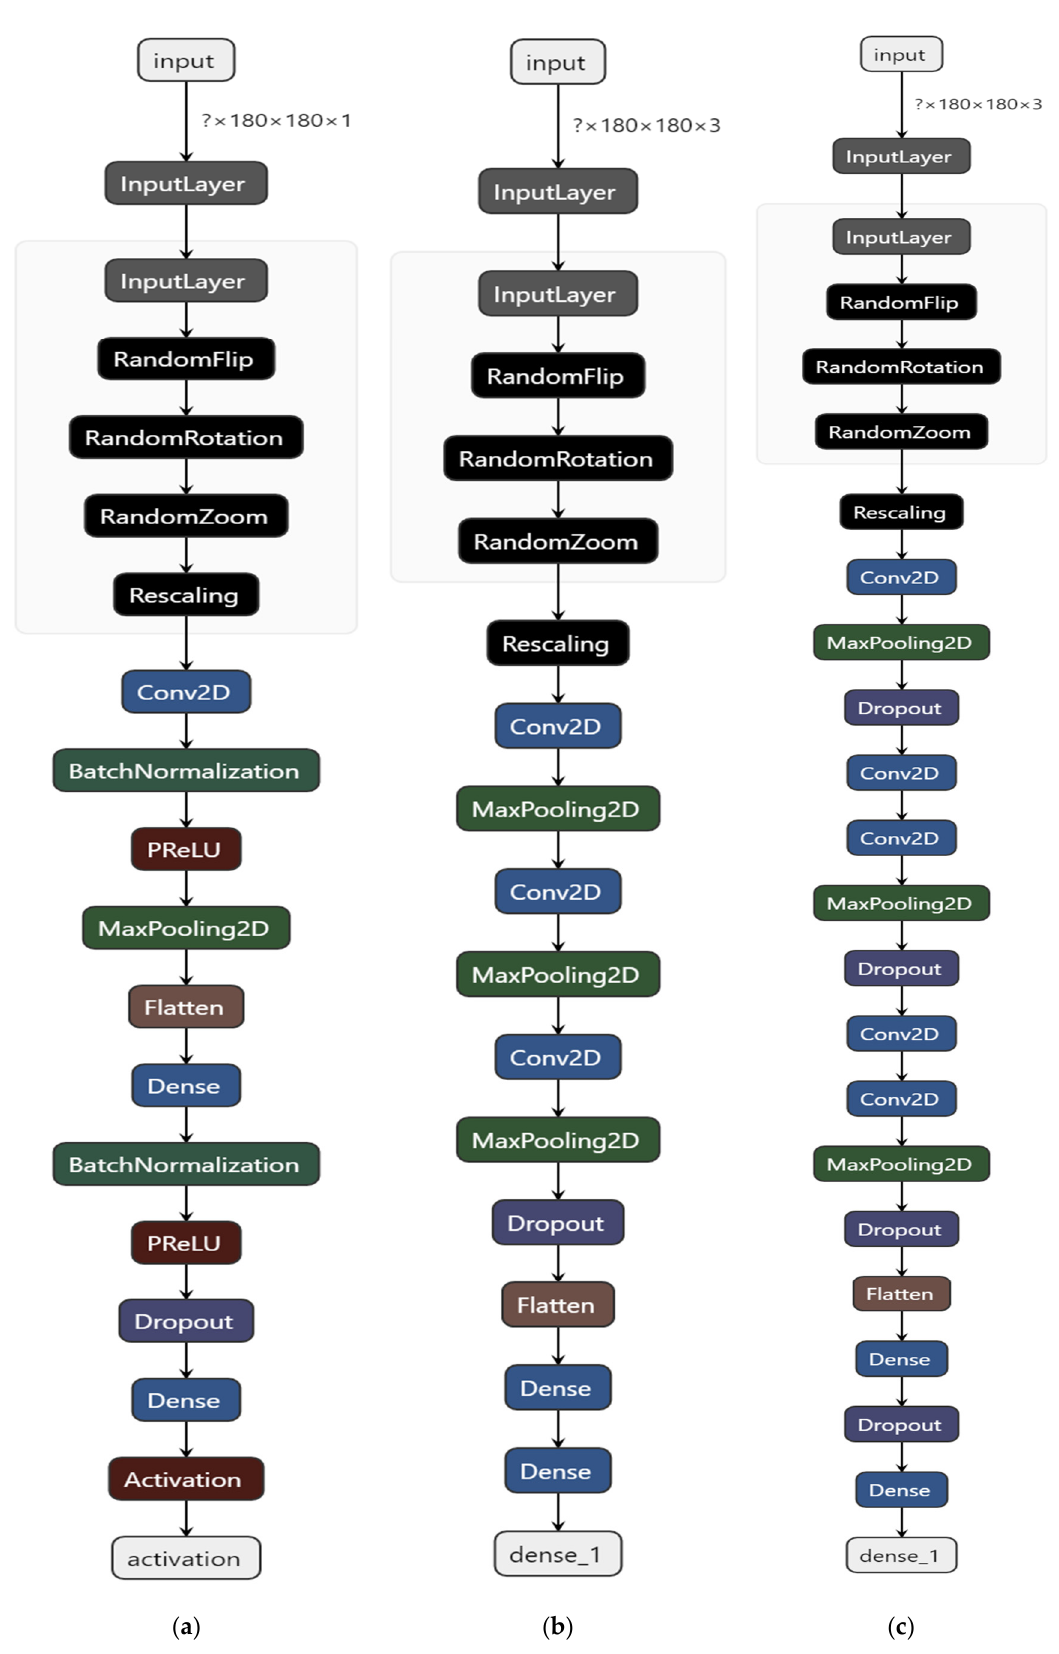
Figure 5 . Custom 2D-CNN architectures: (a) Sequential S – 1 convolutional layer; (b) Sequential M – 3 convolutional layers; Figure 5. Custom 2D-CNN architectures: ( a ) Sequential S —1 convolutional layer; ( b ) Sequential M —3 convolutional layers; (c) Sequential L – 5 convolutional layers. ( c ) Sequential L —5 convolutional